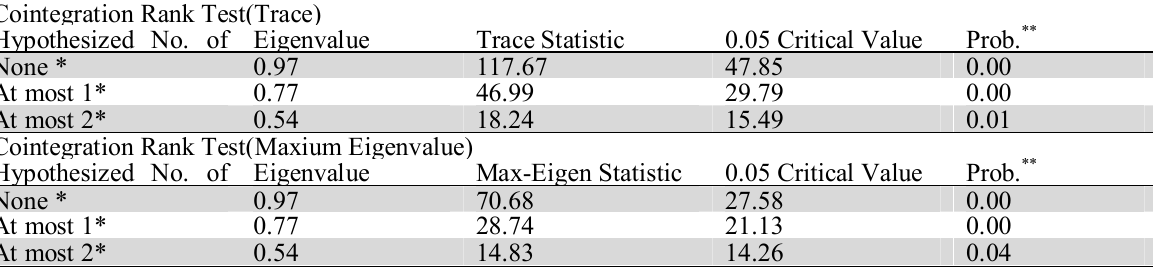
Johansson’s cointegration test